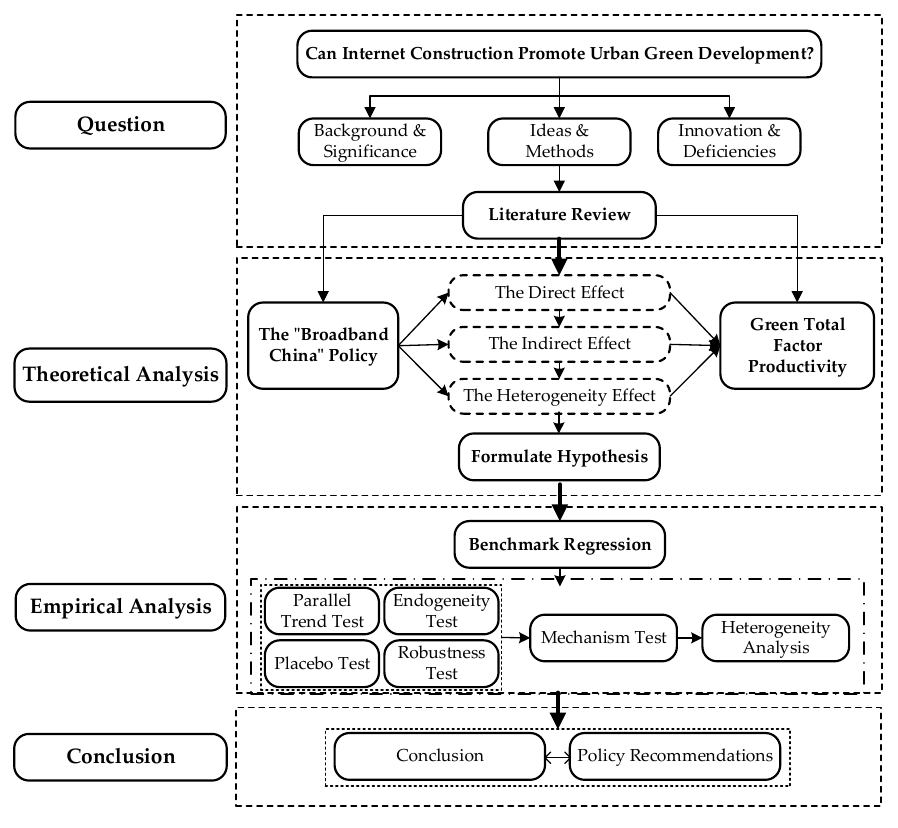
Figure 1. Research